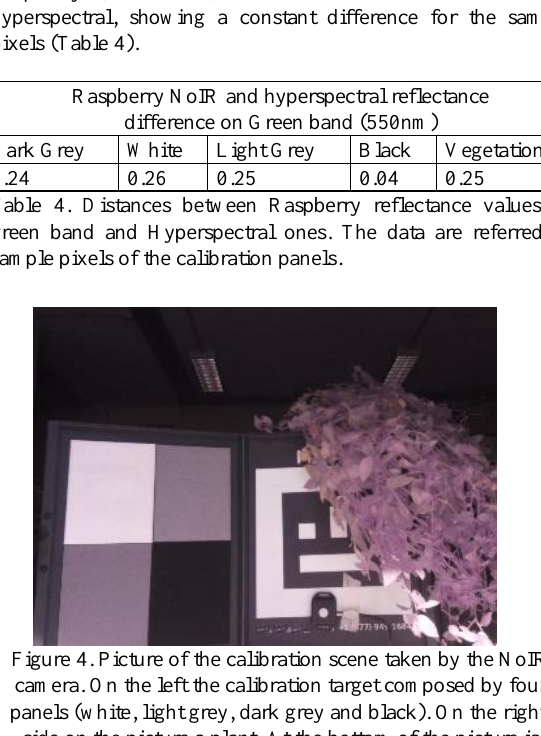
Table 5. Difference between the Band NoIR of the raspberry NoIR and the one of the hyperspectral bands between 640nm and 880nm ion the 5 sample points selected for the comparison.